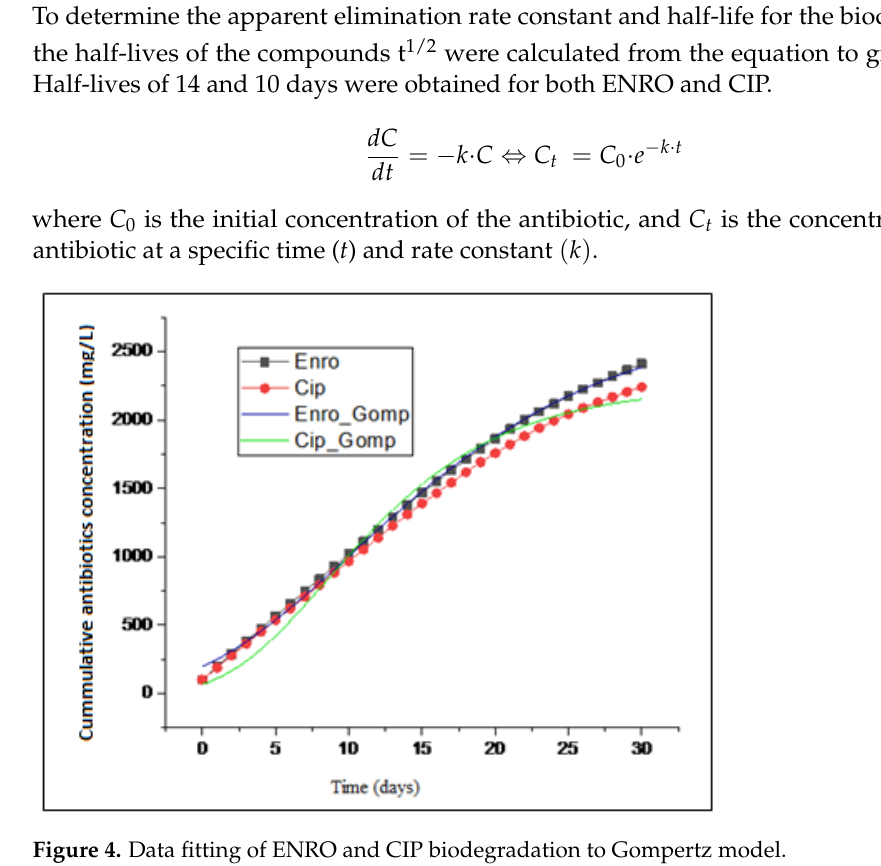
155 Figure 5. Gompertz model patterns. ( a ) CIP residual plot, ( b ) CIP line of best fit, ( c ) ENRO residual 156 plot, ( d ) ENRO line of best fit.